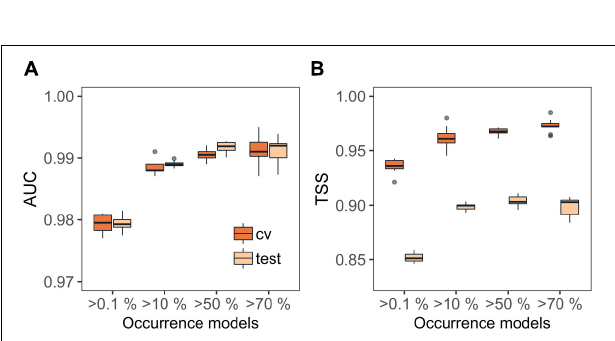
FIGURE 3 | Model performances based on (A) Area Under the Curve (AUC) and (B) True Skill Statistics (TSS). Models were evaluated based on 10-fold cross-validations (CV), and the resulting final model using the full training data and independent test data, set aside from model development